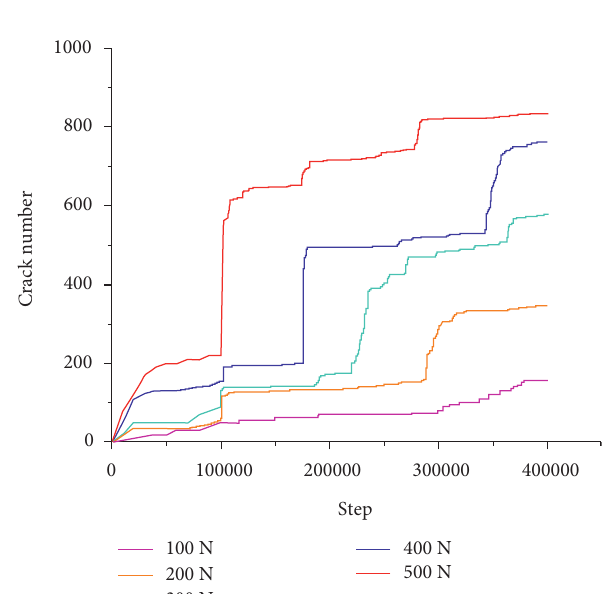
Figure 3: Evolution curve of crack number with time.